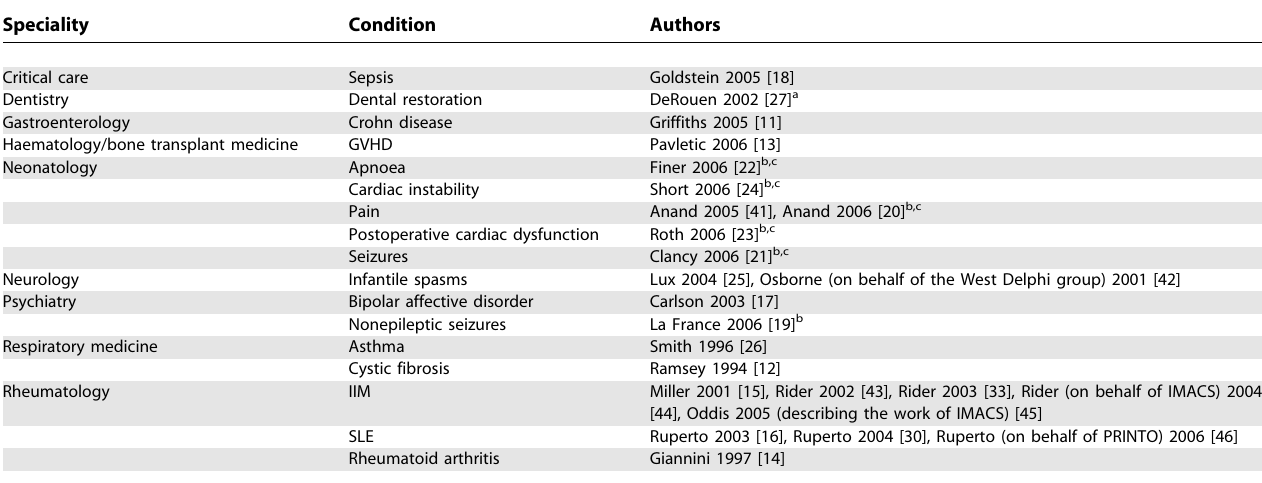
Table 2. Summary of Included